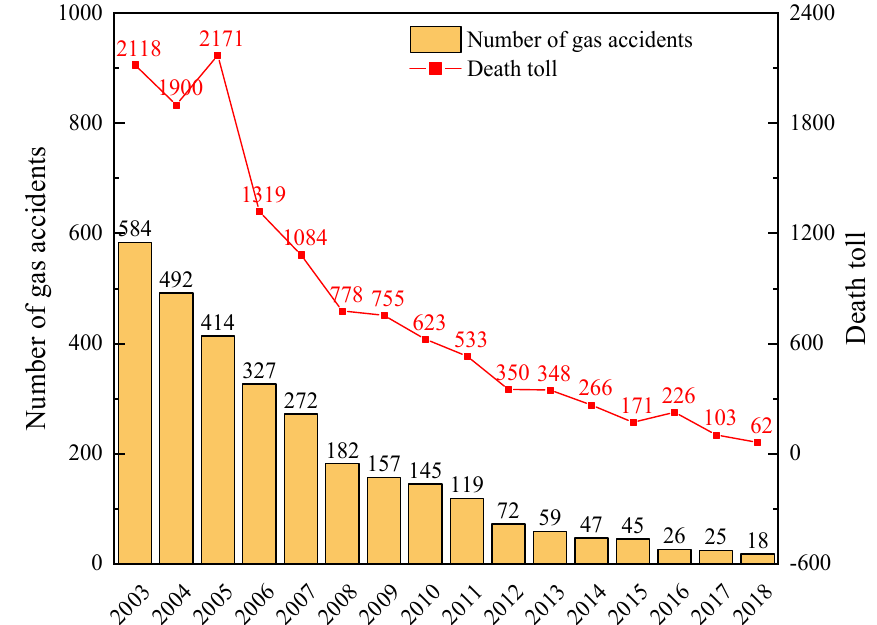
Figure 3. Changes in incidents of and deaths from coal mine gas accidents in China from 2003 to 2018.